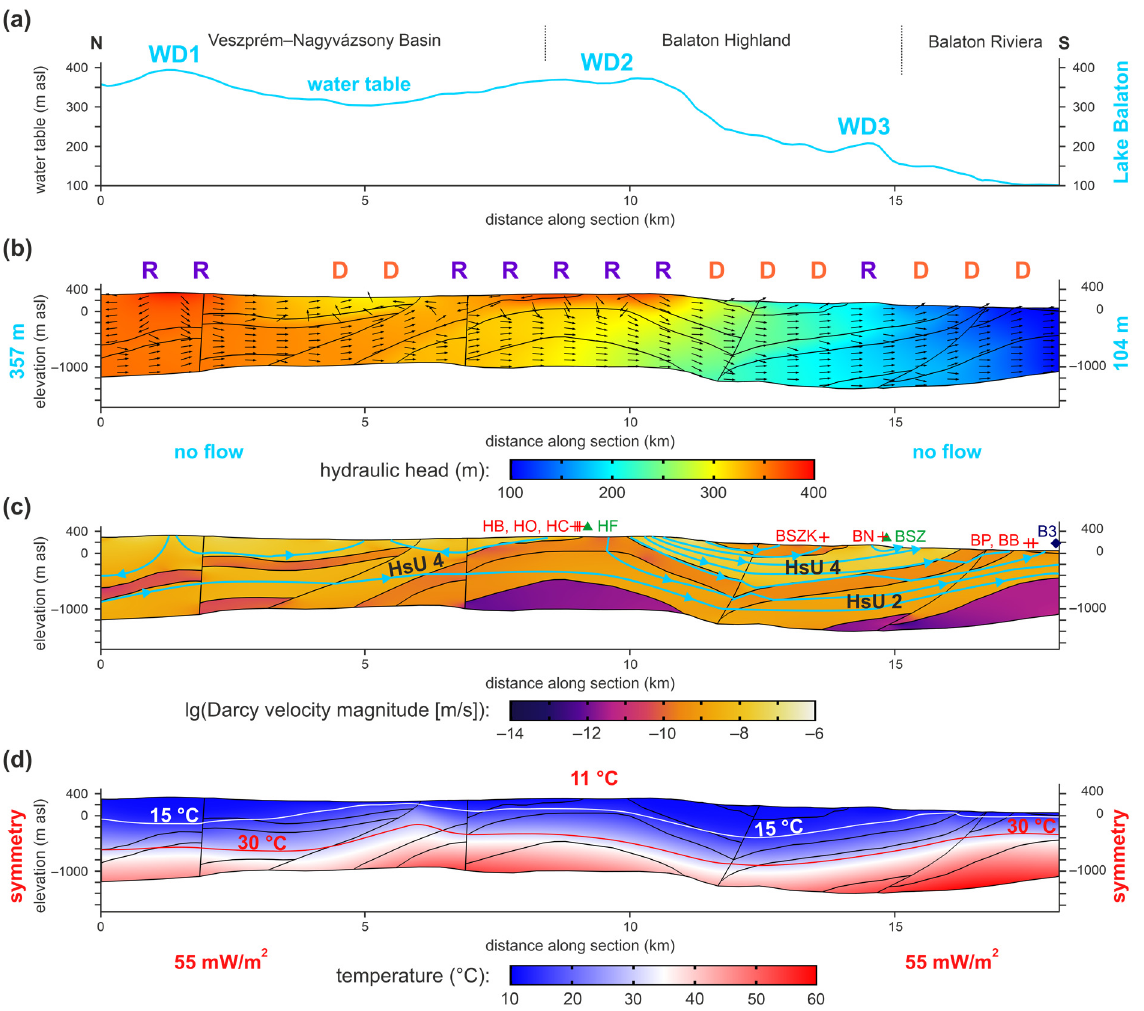
Figure 9. Numerical simulation input and results. ( a ) Water table configuration as upper boundary condition along the surface, indicating water divides (WDs). ( b ) Boundary conditions and the simulated flow pattern showing the hydraulic head and uniform Darcy velocity vector field. R: recharge, D: discharge. ( c ) Base 10 logarithm of Darcy velocity magnitude with characteristic flow lines, sampling sites and uranium-bearing hydrostratigraphic units (HsU 2 and 4). ( d ) Boundary conditions and the simulated temperature distribution with selected isotherms (T = 15 and 30 °C).